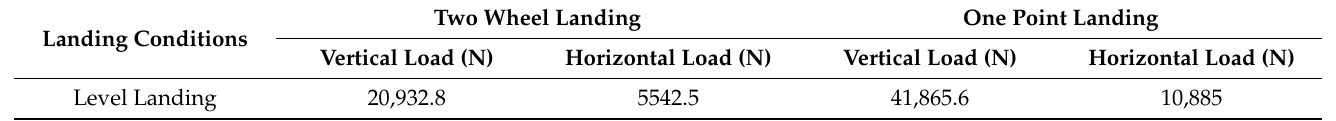
Table 6. Maximum landing load experienced by main landing gear strut upon landing as per FAA FAR 23 and